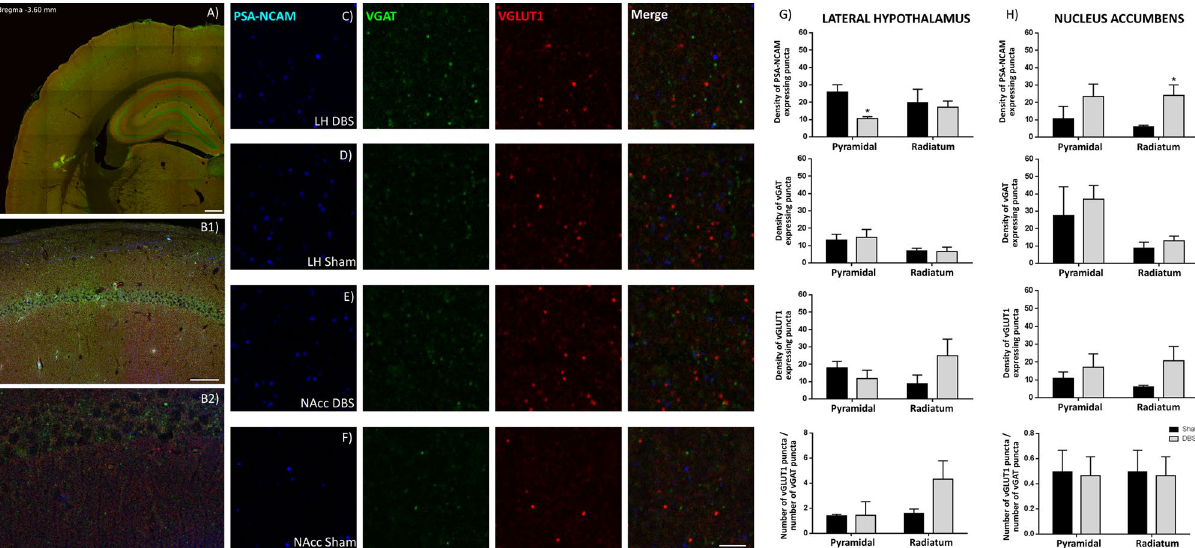
Figure 4. DBS effects on synaptic plasticity in the hippocampus. ( A ) Panoramic view of the dorsal hippocampus immunostained for VGAT and VGLUT1. ( B1 ) Panoramic view of CA1 region. ( B2 ) Detailed view of the strata pyramidale and radiatum . ( C , D ) Expression of molecules related to neuronal plasticity in the stratum pyramidal e of LH stimulated animals ( C ), and LH-sham animals ( D ). ( E , F ) Expression of molecules related to neuronal plasticity in the stratum pyramidal e of NAcc stimulated animals ( E ) and in NAcc-sham animals ( F ). ( G , H ) Graphs showing the density of puncta (number of puncta/900 µm 2 ) expressing PSA-NCAM, VGAT, VGLUT1 and the E/I balance in the rats receiving stimulation in the LH ( G ) and the NAcc ( H ). Student’s T-test, p -values: * < 0.05). VGAT vesicular GABA transporter; VGLUT vesicular glutamate transporter 1. Scale bar 500 µm for ( A ), 50 µm for ( B1 ), 20 µm for ( B2 ), 3 µm for ( C – F ).